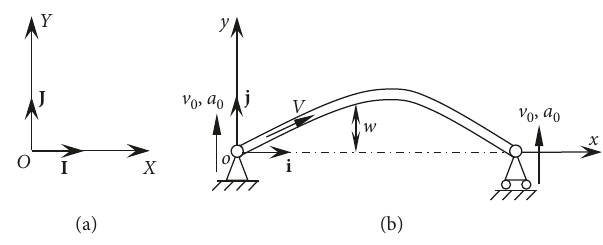
Figure 1: PCF with lateral moving supports.